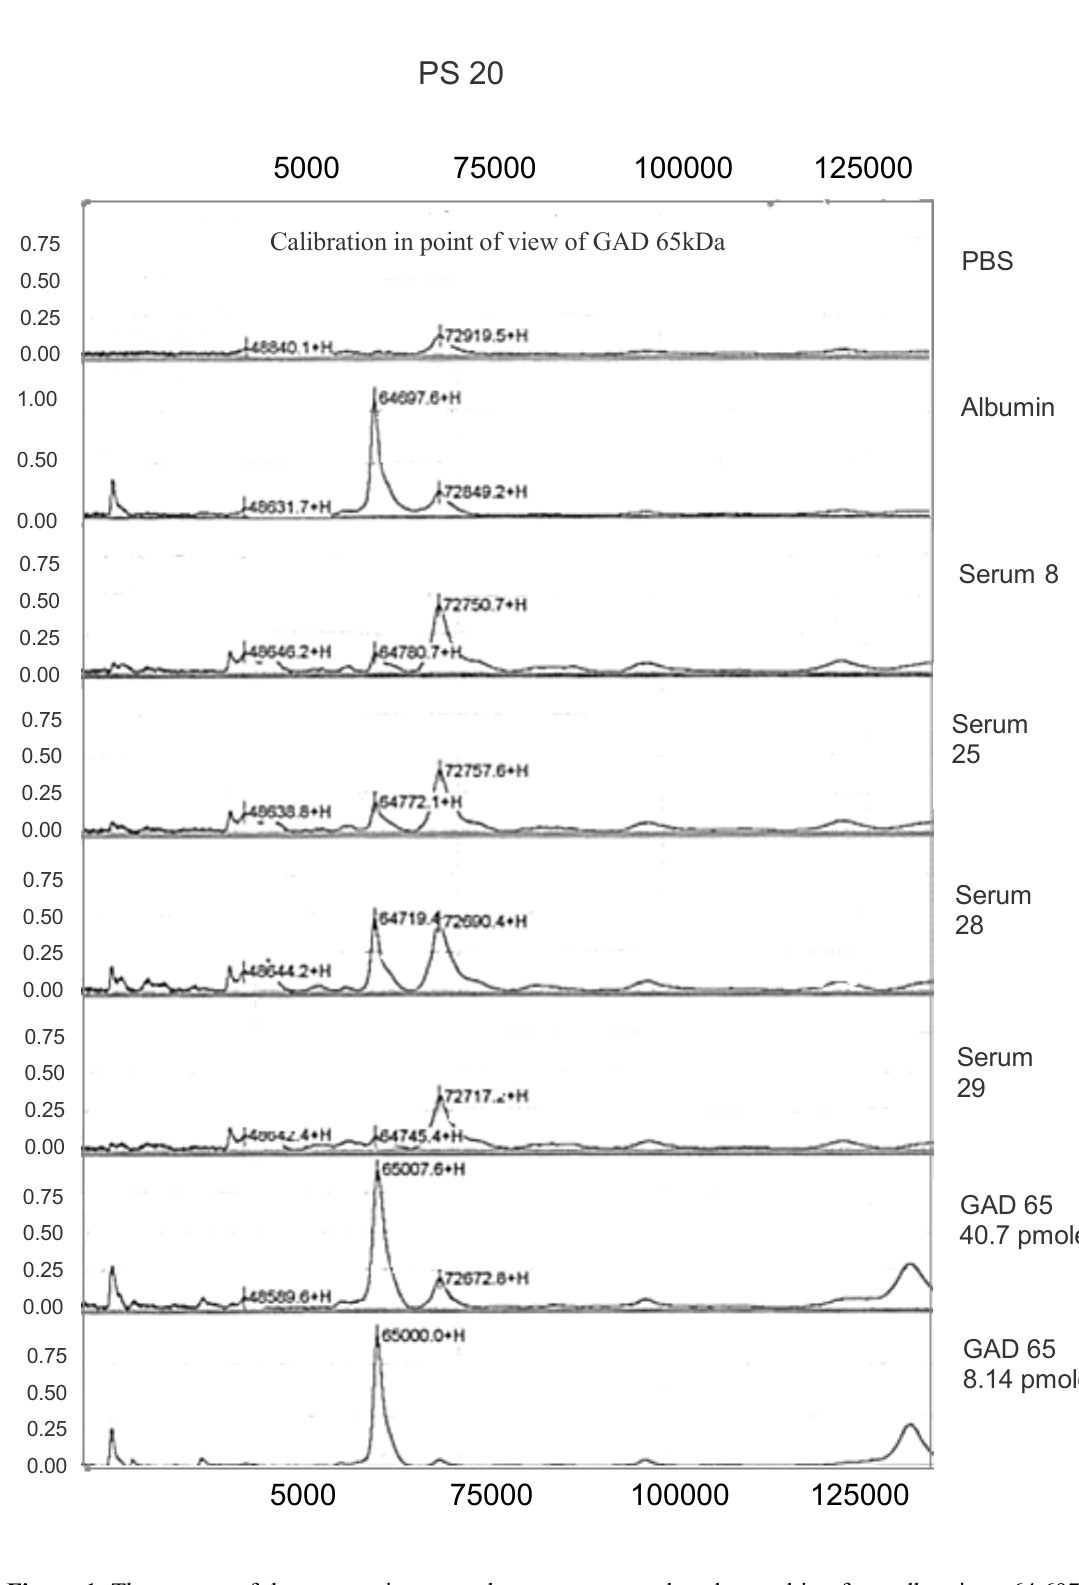
Figure 1. The spectra of the pure patient sera show very exposed peaks resulting from albumin at 64.697 kDa. The peaks at 50, 75 and 150 kDa result from the antibodies. Because the expected GAD molecule has a molecu- lar weight near albumin (65 kDa), identification in patient sera under these experimental conditions is not possi-